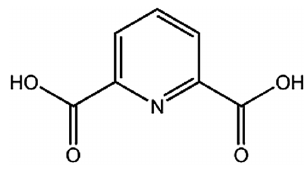
Figure 1 The molecular structure of 2 ·H omitted for